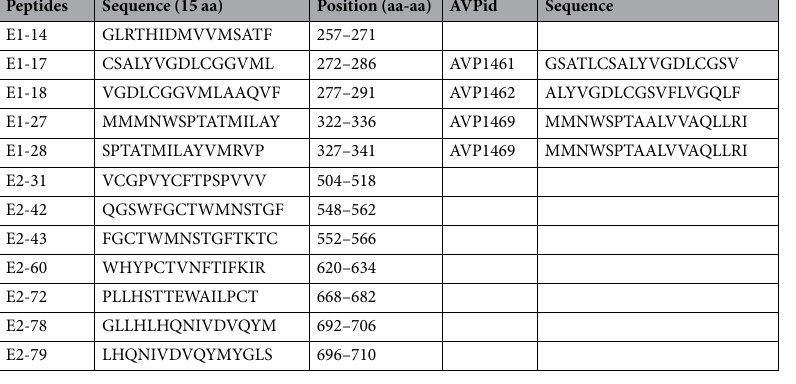
Table 1. Anti-HCV peptides in our